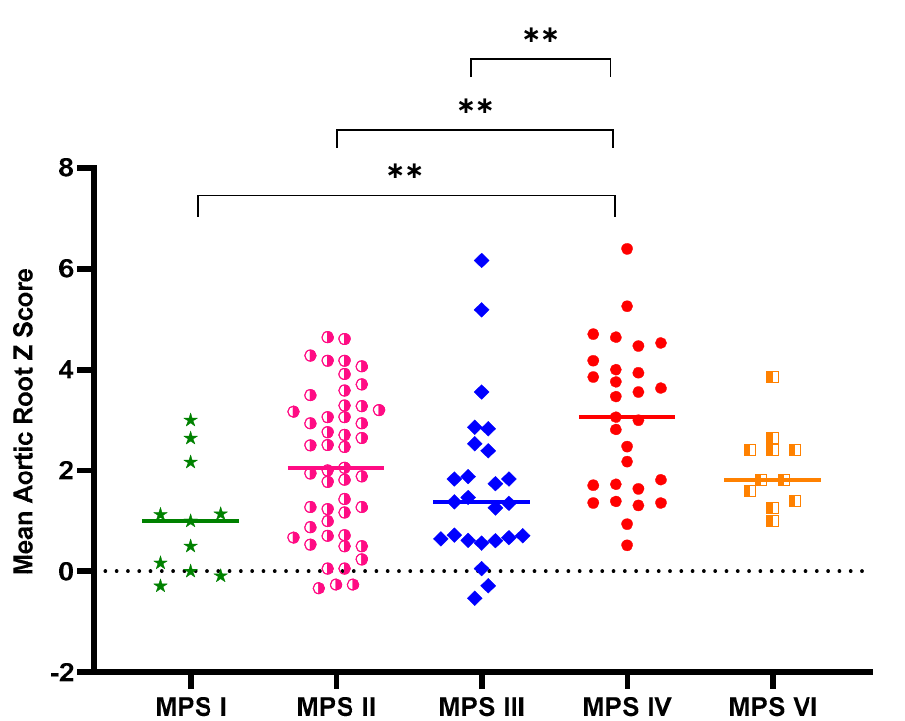
Figure 1. Aortic root diameter z score in the patients with different types of MPSs ( n = 125) (** p < 0.01). There were significant differences in aortic root diameter z scores between those with MPS IV and MPS I, MPS IV, and MPS II, as well as MPS IV and MPS III (all p < 0.01).